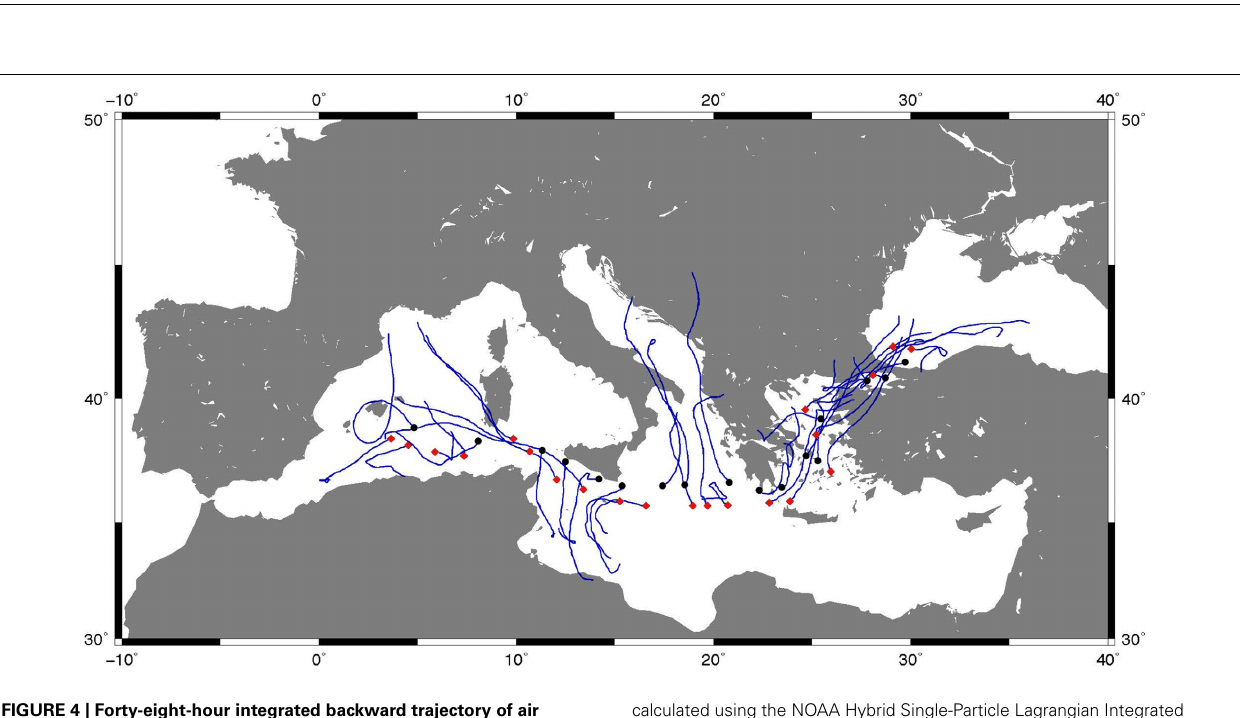
FIGURE 4 | Forty-eight-hour integrated backward trajectory of air masses reaching the sampling sites in the Mediterranean Sea (Transect 1: black dots; transect 2: red triangles). Air mass trajectories were